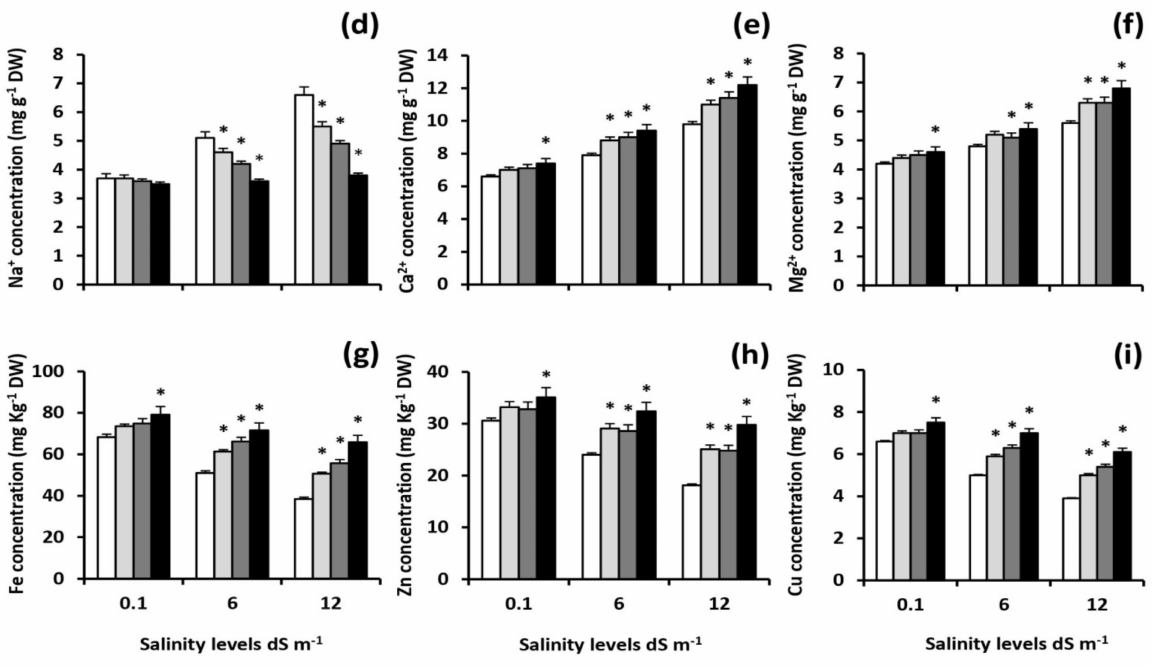
Figure 1. Influence of salicylic acid (SA, 75 mg L − 1 ), melatonin (MT, 70 µ M), and SA (75 mg L − 1 ) +